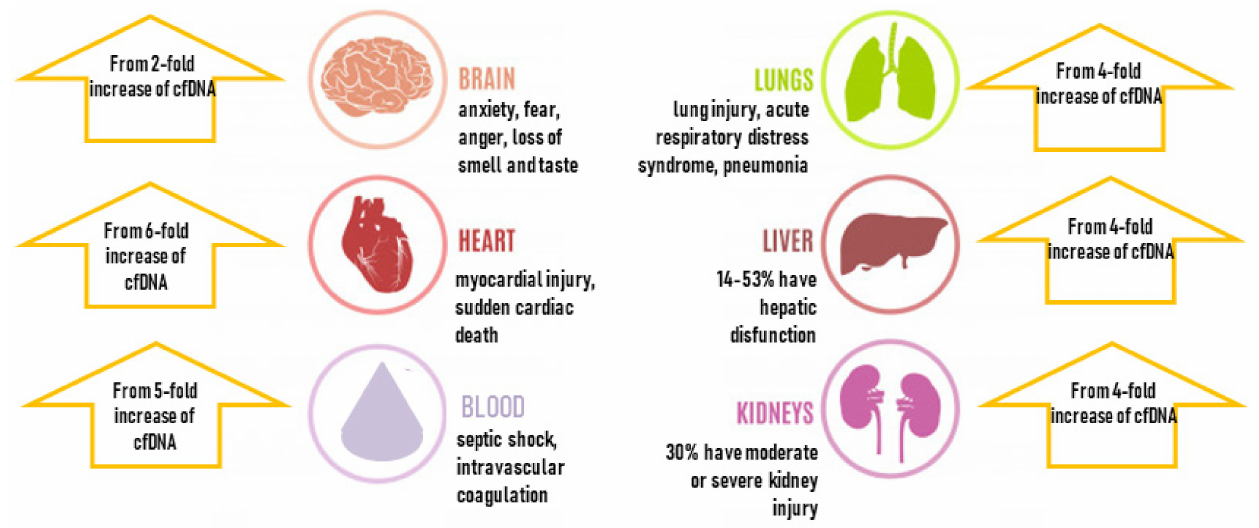
Figure 3. Scheme showing the most common complications of COVID-19 in the context of cell-free DNA fold changes